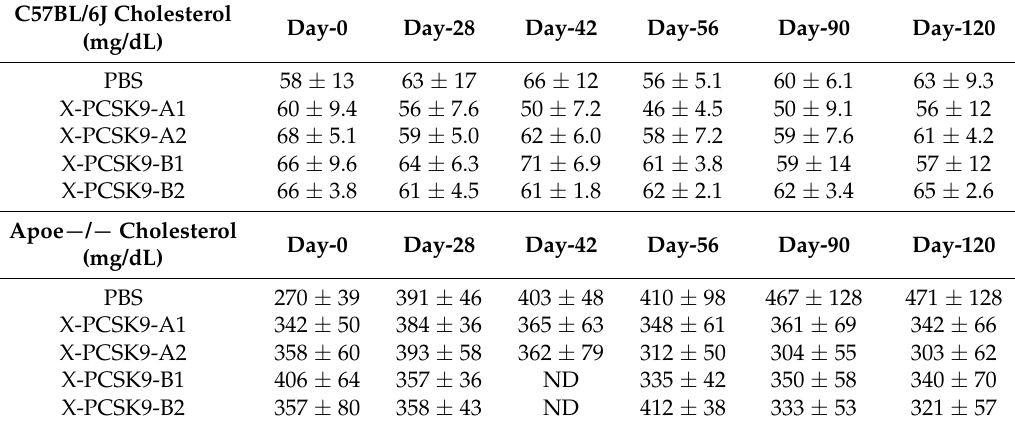
Table 2. Plasma cholesterol levels in C57BL/6J and Apoe − / − mice after X-PCSK9 isomers A1, A2, B1 and B2 immunogen treatment. Each value represents the average fasting plasma concentration of 5 mice at the indicated time. The results are expressed as mean ± S.D. ND = not determined.